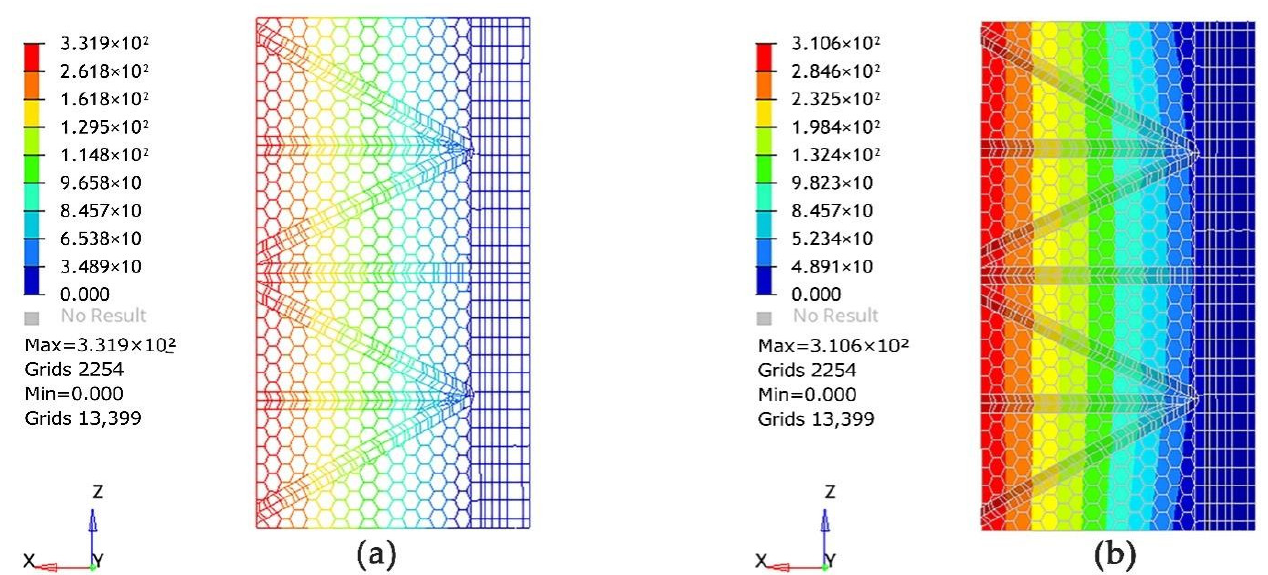
Figure 12. Numerical plots of model II stiffness for permanent loads. ( a ) Deflection diagram under self-weight of model II skeleton structure. ( b ) Deflection diagram of model II skeleton with mem- brane fabric under self-weight.